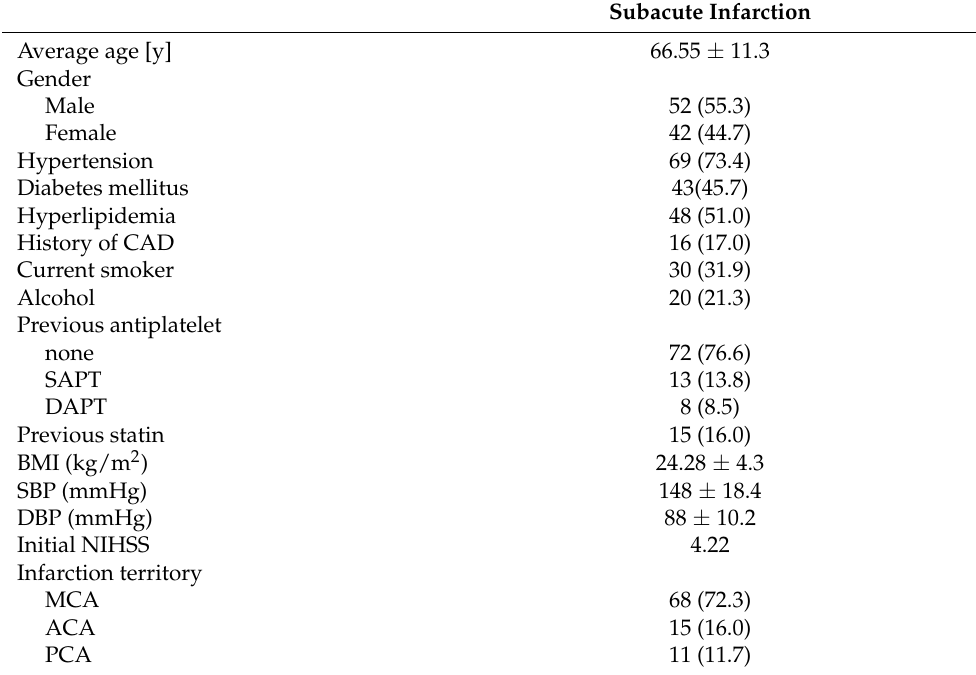
Table 1. Clinical and radiologic characteristics of subacute